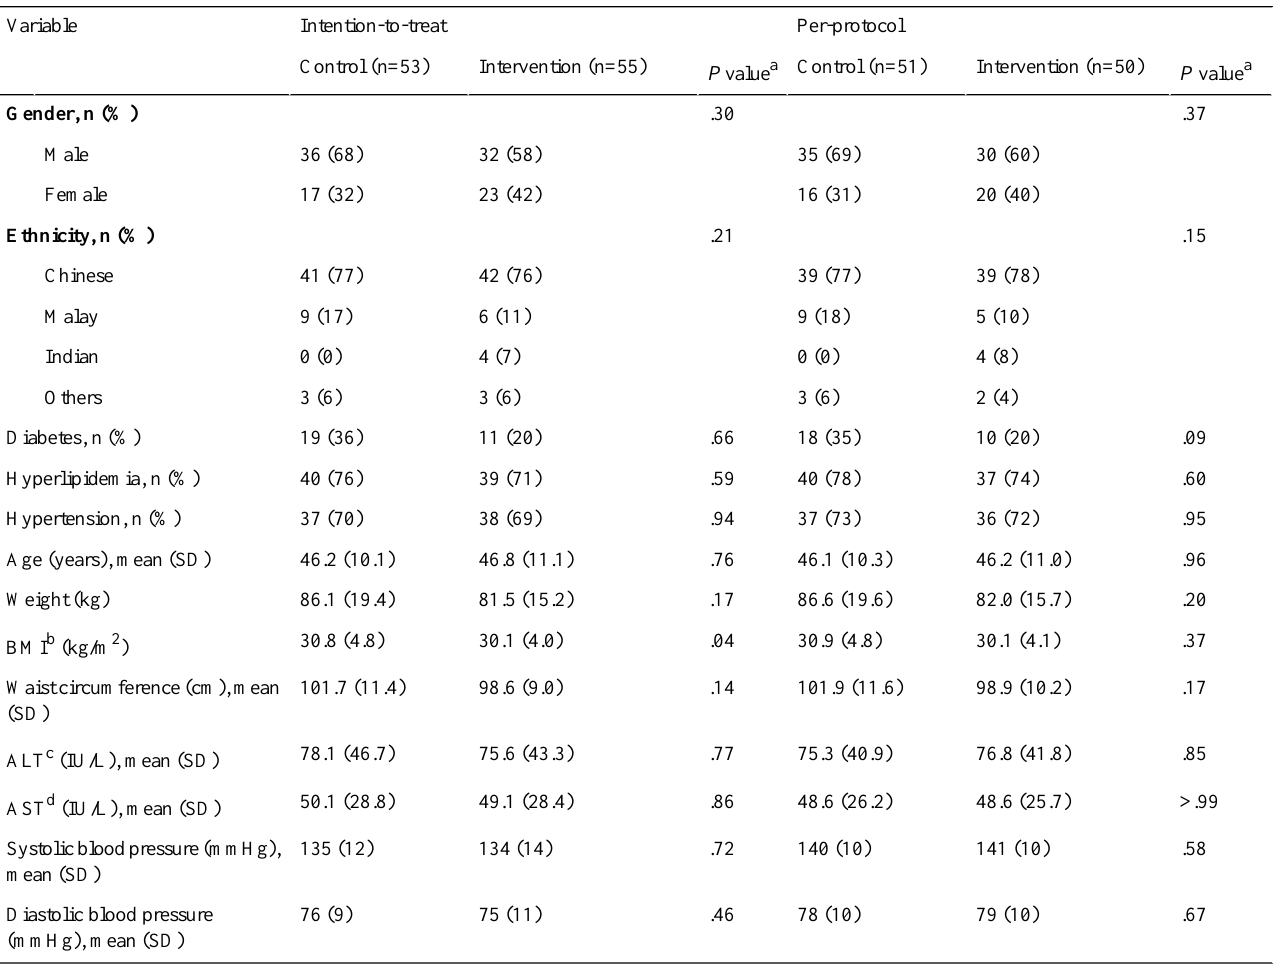
Table 1. Baseline characteristics of study participants.